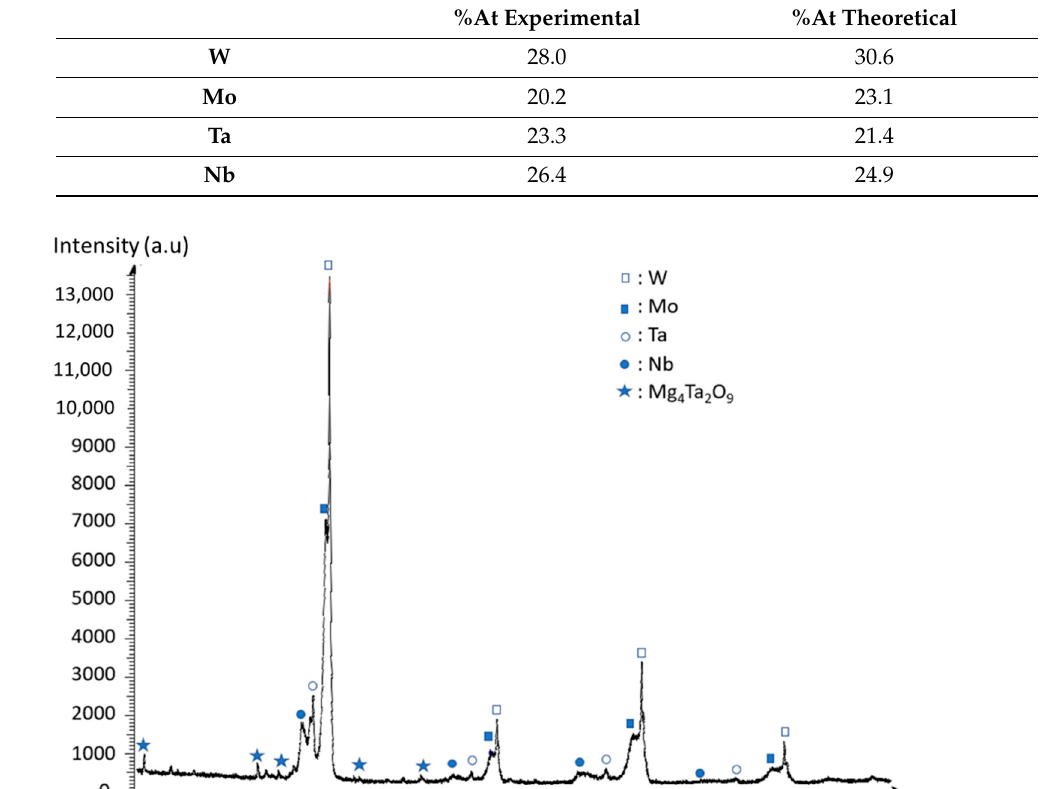
Table 1. X ‐ ray fluorescence analysis on WMoTaNb powder prepared by SHS.